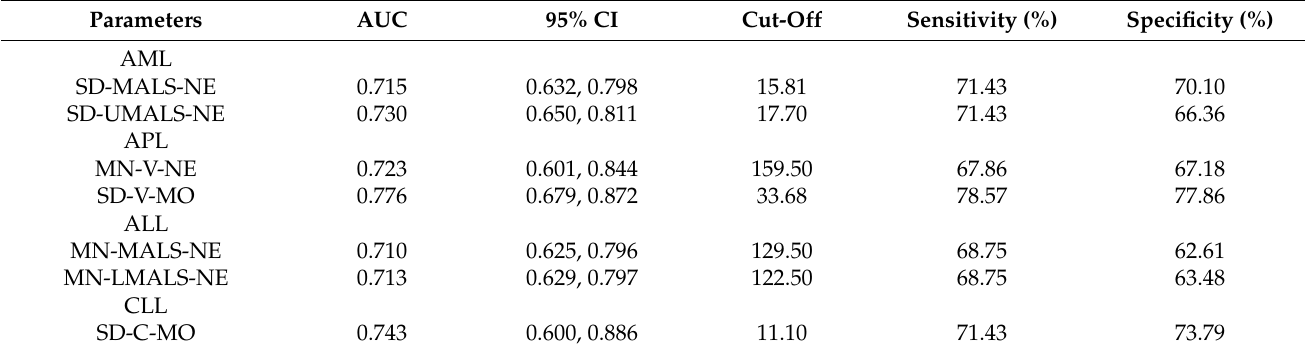
Table 3. The ROC data for each leukocyte CPD to distinguish subtypes of